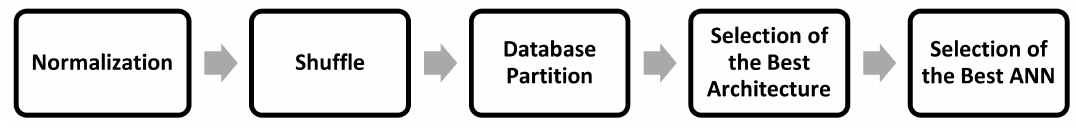
Figure 8. Development process for the model